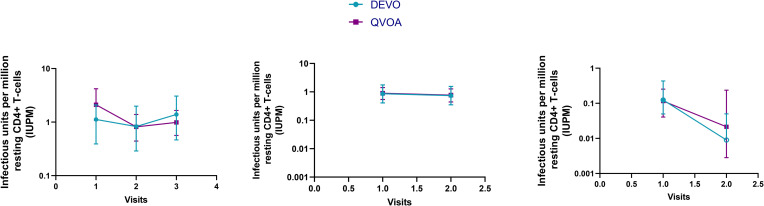
The DEVO assay tracked similarly overtime as the traditional QVOA. The DEVO assay and QVOA were performed with resting CD4 + T cells collected at multiple time points from 3 participants, DV-01 (first panel), DV-09 (second panel), and DV-04 (third panel). All assays were performed using cells from the same leukapheresis donation, except for VV-09 where the DEVO was performed using cells from whole blood donated within 3 months of leukapheresis donations used for the QVOA. The time elapsed between visits 1 and 2, 1 and 3, and 2 and 3 for DV-01 is 7.9, 14.1, and 6.2 months respectively; for DV-09 the time elapsed between visit 1 and 2 is 17.9 months (DEVO) and 14.9 months (QVOA); For DV-04, the time between the first and second donation is 15. 9 months. IUPM + 95% CI (upper and lower limits) is shown.